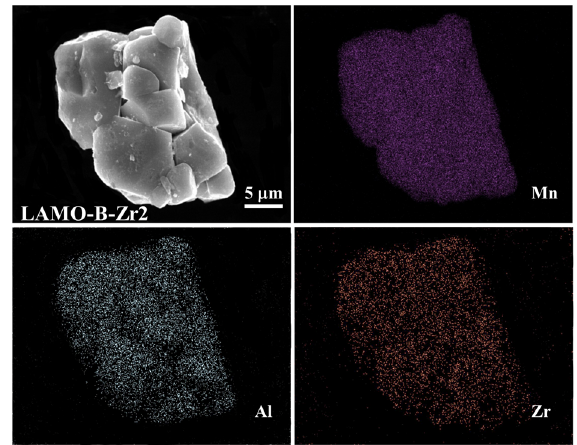
Figure 3. The SEM images of the ( a ) LAMO-B-Zr1; ( b ) LAMO-B-Zr2; ( c ) LAMO-B-Zr3 and ( d ) LAMO-B-Zr4 samples.